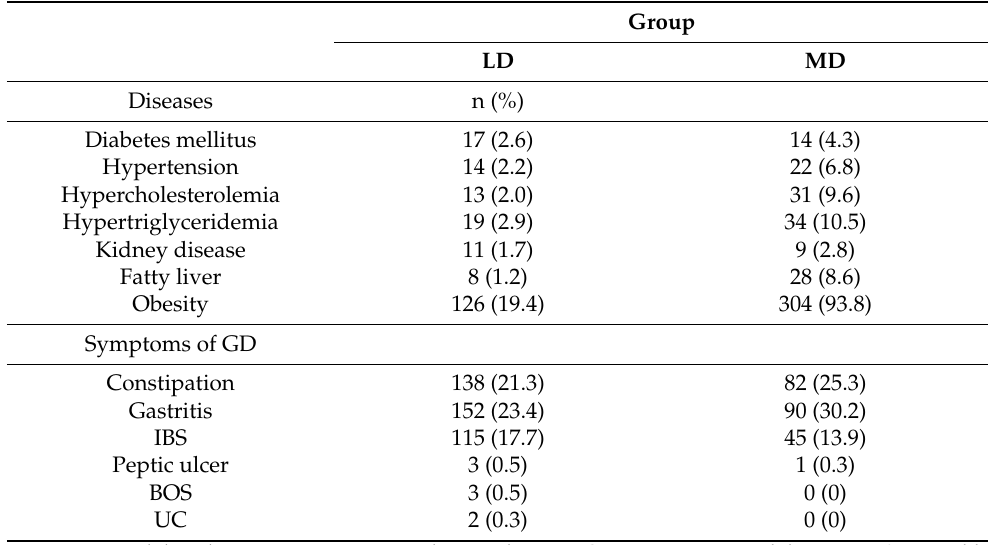
Table 3. Distribution of diseases in the LD and MD groups.